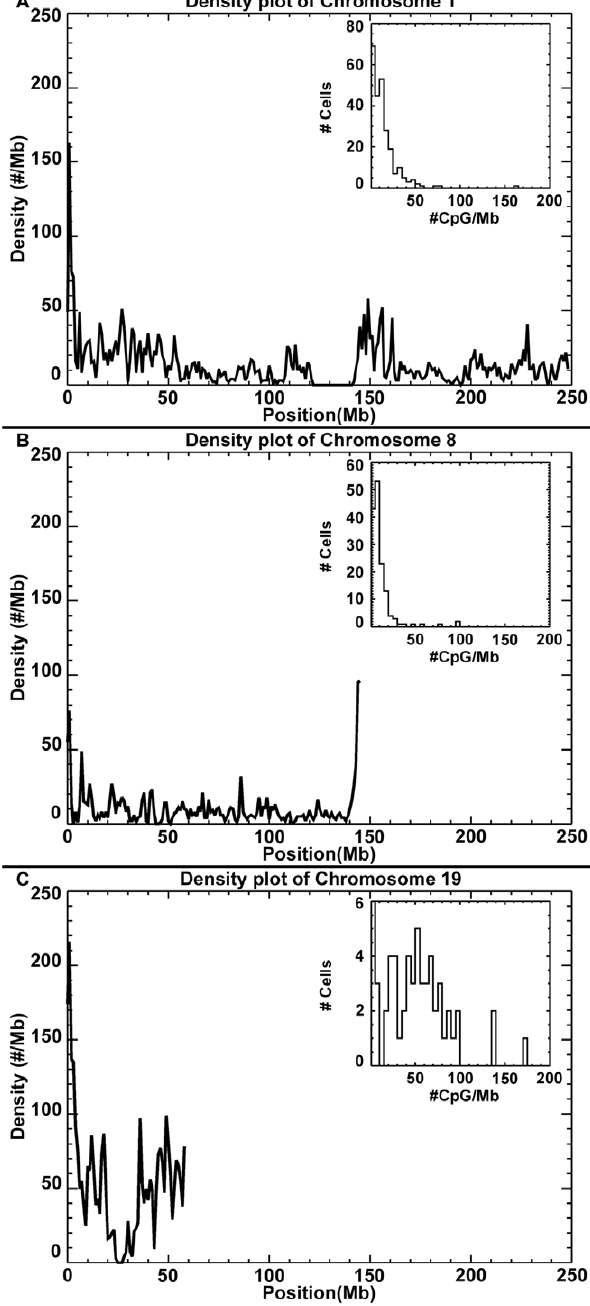
Figure 1. Density plots for chromosomes 1, 8 and 19. Densities are defined as the number of CGI per 1 Mb window. Note the especially high density at the 5 9 telomere and the missing sequence at position , 130 Mb. Inset shows the distribution of densities in the 249 1 Mb windows that comprise the chromosome. The distribution is skewed and demonstrates that simple estimators of the centroid and dispersion are insufficient. Plots for all chromosomes are given in Text S1.